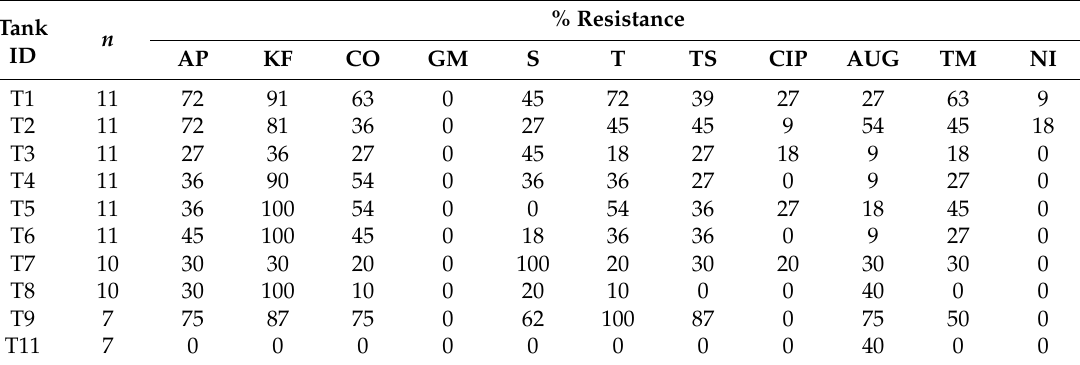
Table 4. Antibiotic resistance among E. coli strains isolated from various rainwater tanks. Tank ID